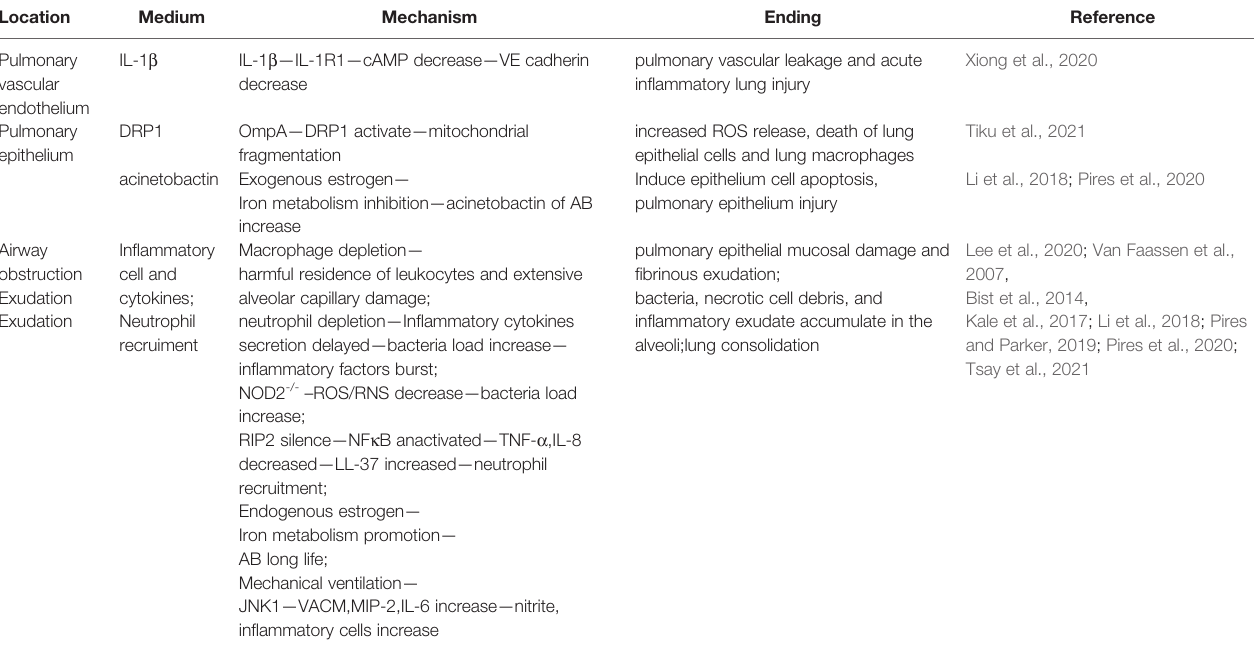
TABLE 2 | Mechanism of lung